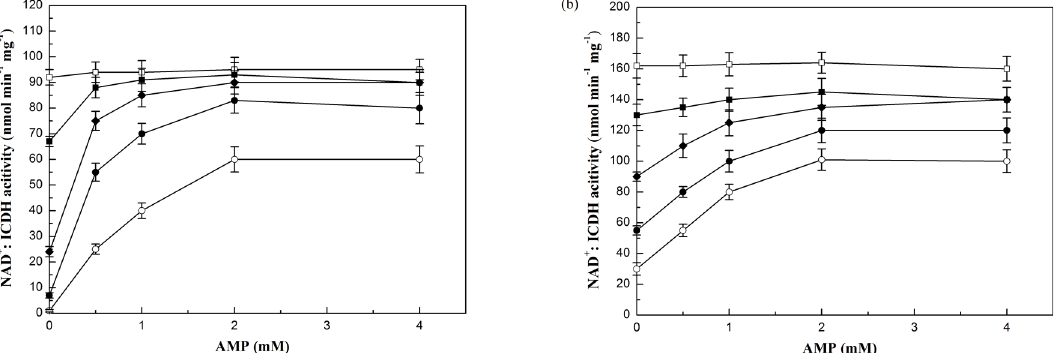
Fig 4. Effect of AMP concentration on NAD + :ICDH activity in M . circinelloides WJ11 (a) and CBS 277.49 (b). The activity of NAD + :ICDH of the cell extract at 24 h grown in the modified K & R medium in 2L fermenter was measured, in vitro, in the presence and absence of AMP at different isocitrate concentrations. Isocitrate concentrations: 0.1 mM ( (cid:4) ); 0.5 mM ( ● ); 1 mM ( ◆ ); 2 mM ( ▀ ); 5 mM ( □ ). Values are mean of three biological replicates. Error bars represent the standard error of the mean.